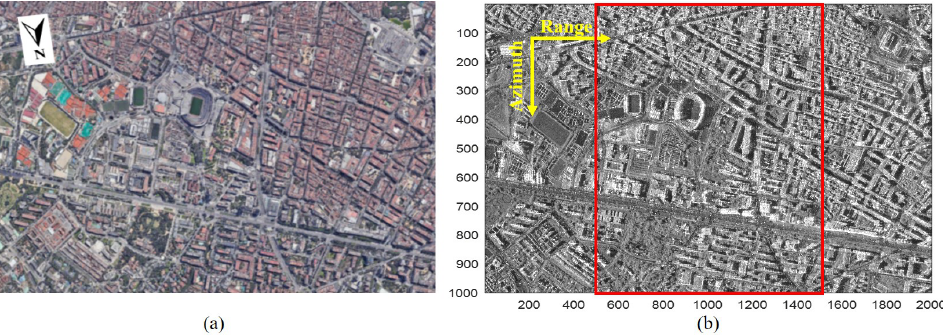
Figure 7. The study area of real data experiments: ( a ) optical image in Google Earth; ( b ) the average amplitude of 24 SAR